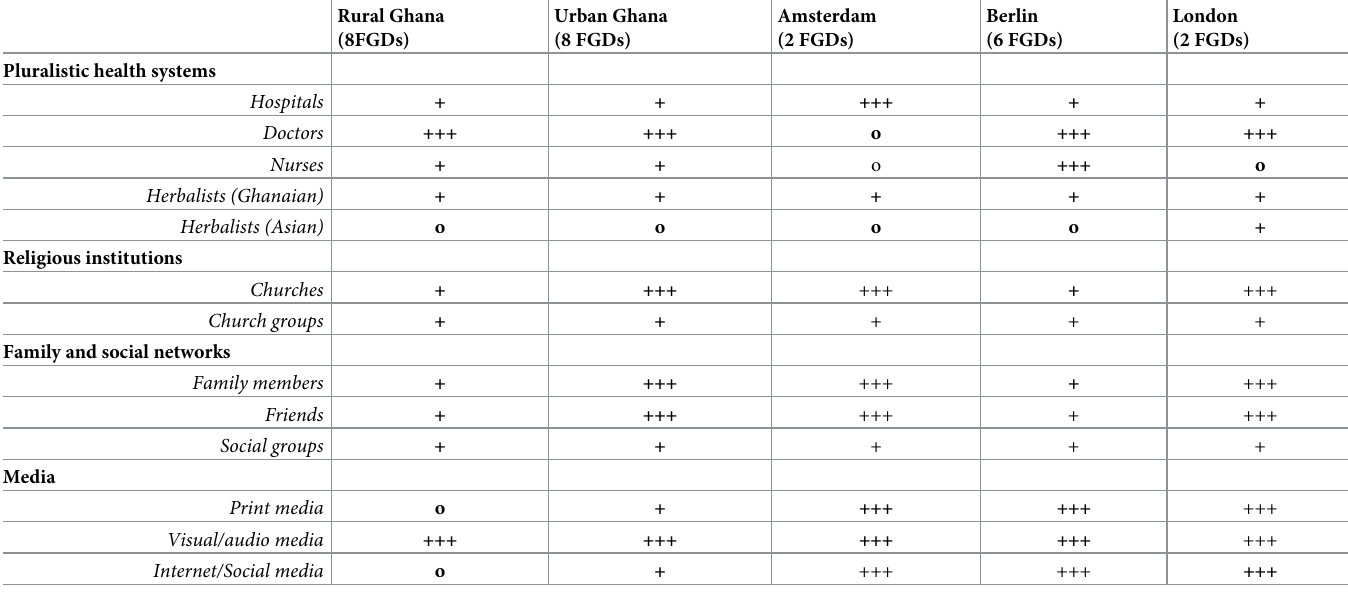
Table 3. Spread and dominance of sources of T2D knowledge across the five study